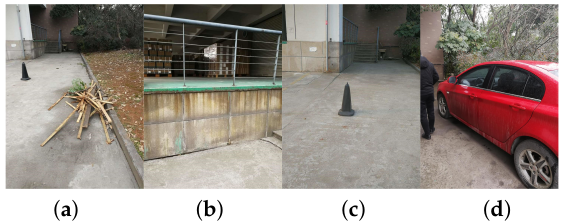
Figure 14. Situations of the collision with obstacles: ( a ) The wood, ( b ) The fence, ( c ) A traffic cone, ( d ) A